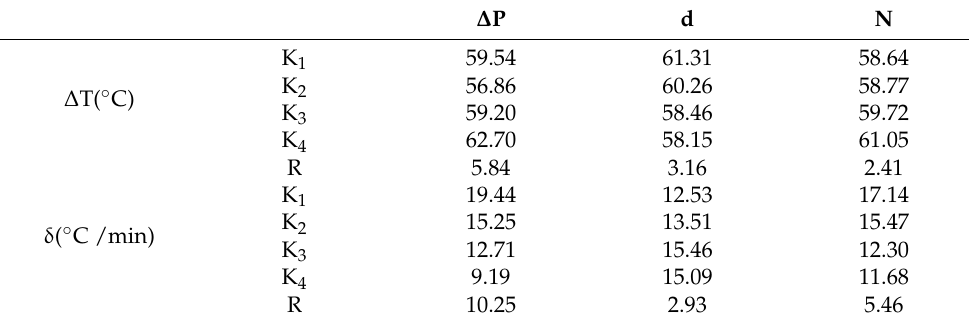
Table 8. Analysis of the